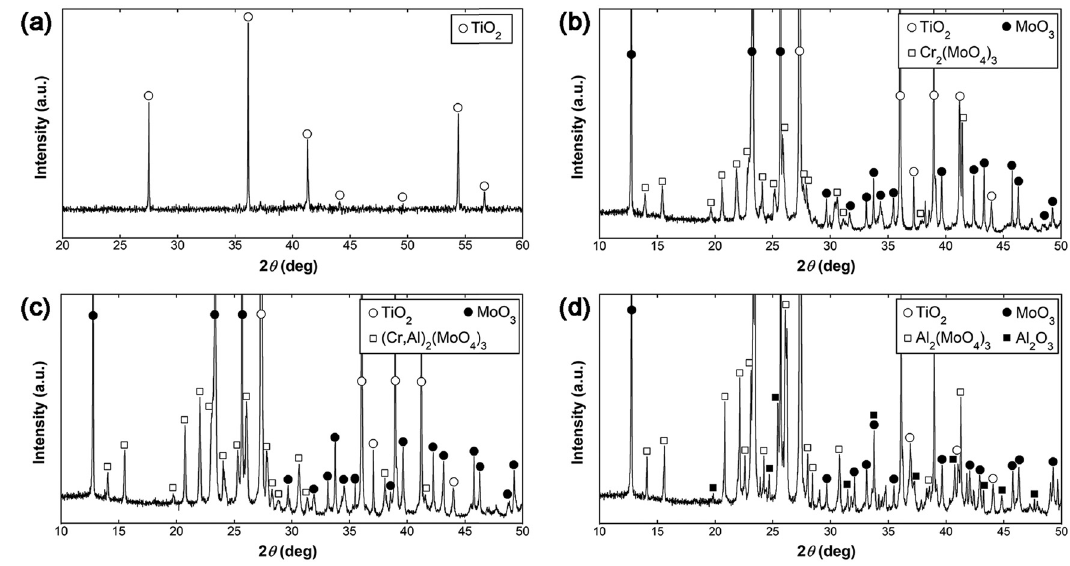
Figure 4: XRD spectra of the ( a ) base, ( b ) 10Cr, ( c ) 5Cr5Al and ( d ) 10Al alloys after 50 h oxidation at 800°C.